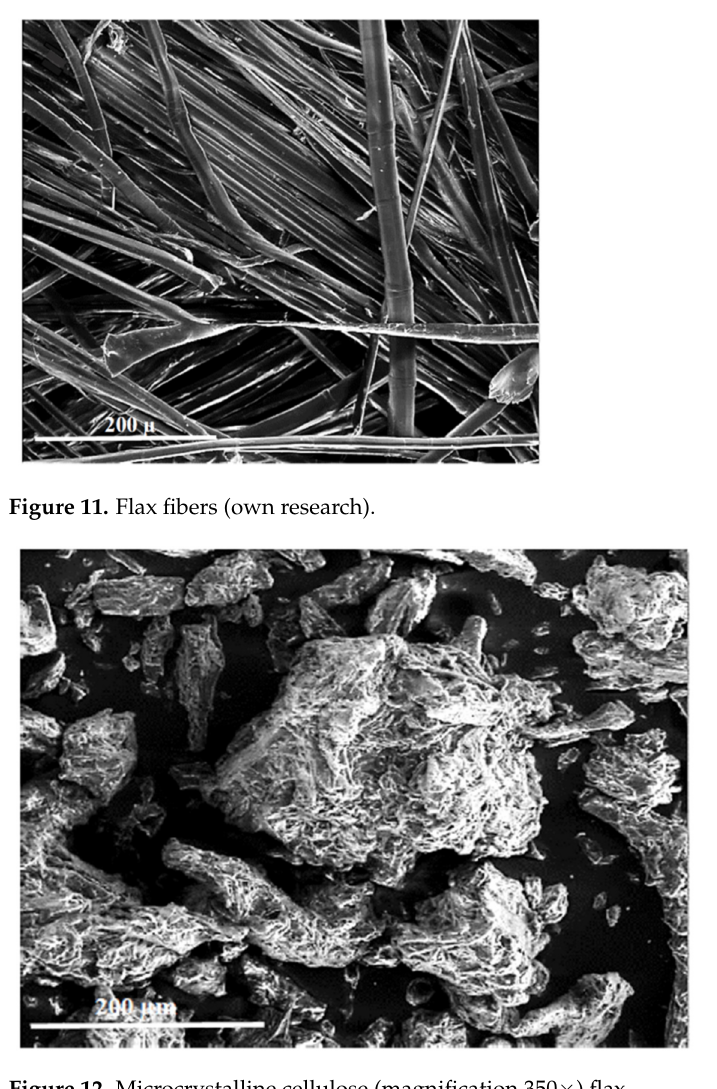
Figure 12. Microcrystalline cellulose (magnification 350 × )